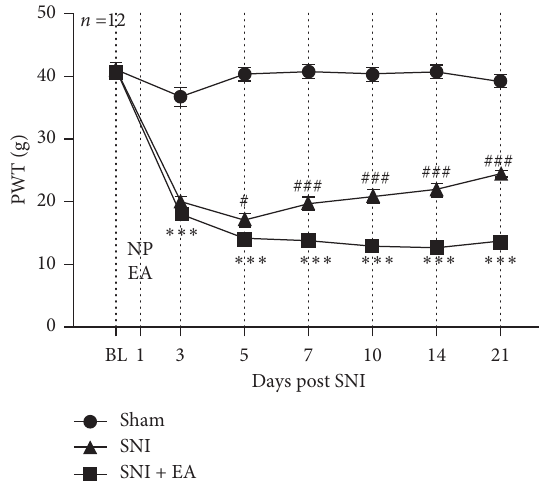
Figure 2: Effect of 2Hz EA on mechanical paw withdrawal threshold evoked by SNI. Rats were treated with 2Hz EA stimu- lation once every other day for 21 days postsurgery. Sham rep- resents the sham group; SNI represents rats treated with the spared nerve injury-induced neuropathic pain; SNI +EA represents rats receiving spared nerve injury and 2Hz EA treatment. ∗∗∗ P < 0 . 001, compared to the sham group; ### P < 0 . 001, compared to the SNI group. All data were expressed as the mean ± SEM, n � 12 per group. Two-way repeated-measures ANOVA followed by Bon- ferroni’s post hoc